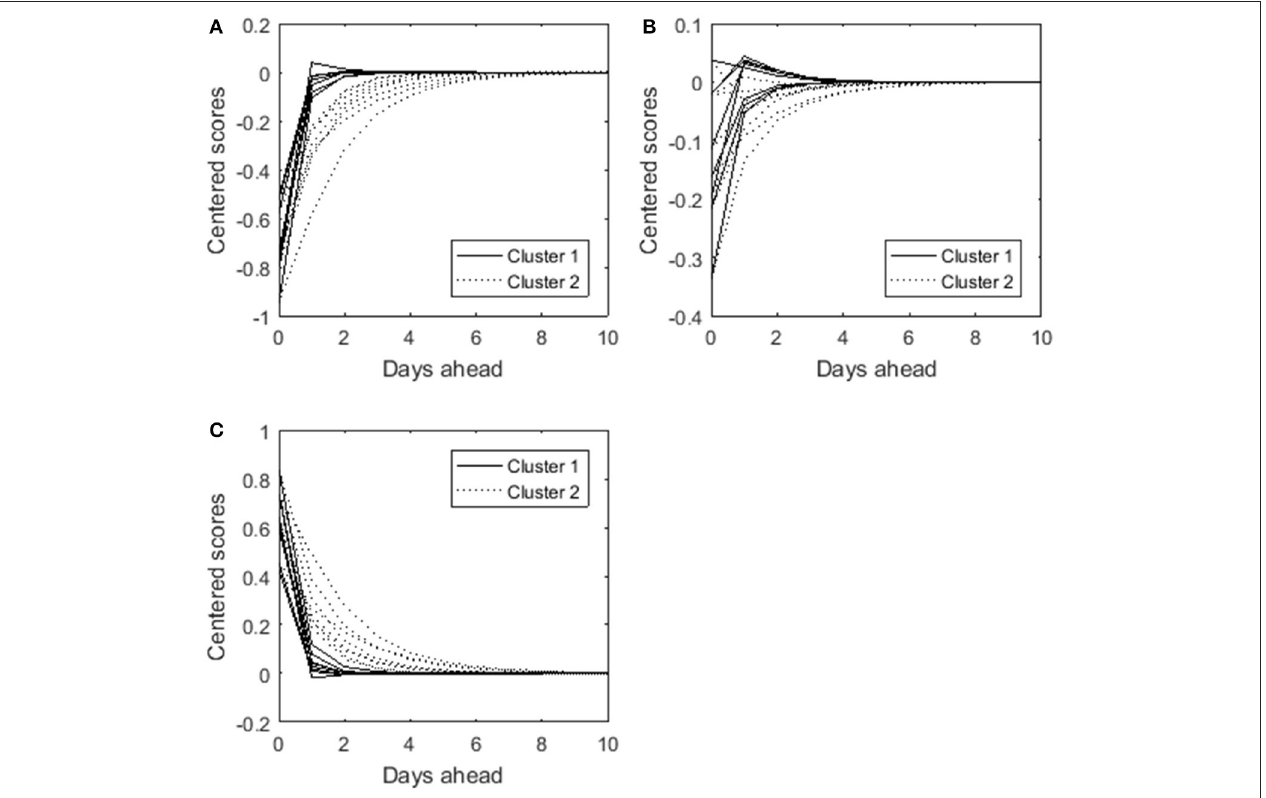
FIGURE 8 | Ten days ahead predicted scores for the eight different depression-related symptoms. The solid lines show the predictions for the first cluster, and the dotted lines for the second cluster. The starting condition (i.e., zero days ahead) in (A) is that each variable score equals its first quartile, in (B) that each variable score equals its second quartile, and in (C) that each variable score equals its third